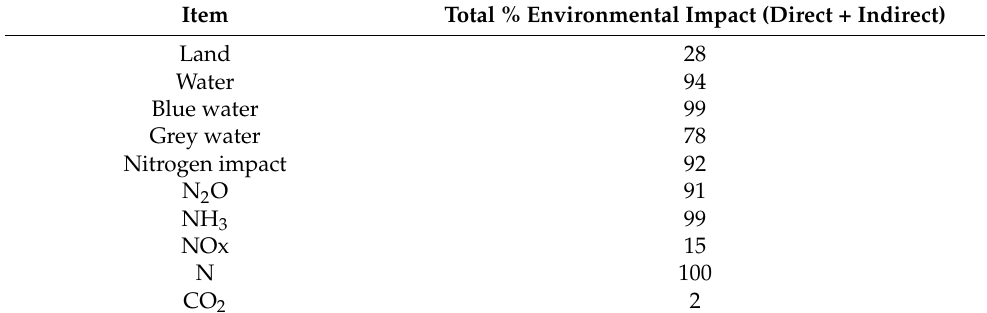
Table 4. The contribution of Pakistan’s agriculture sector’s total (direct + indirect) environmental impacts to Pakistan’s total sectoral environmental impacts.